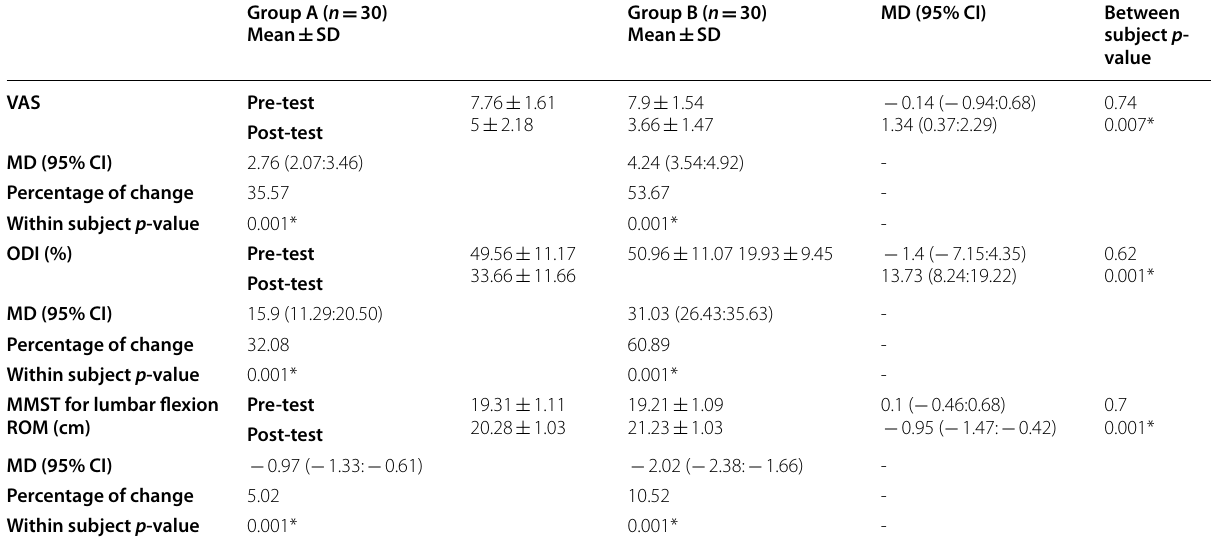
SD Standard deviation, MD Mean difference, CI Confidence interval, p-value , level of significance, MMST Modified-Modified Schober test, ROM Range of motion * The significant level was set at p <